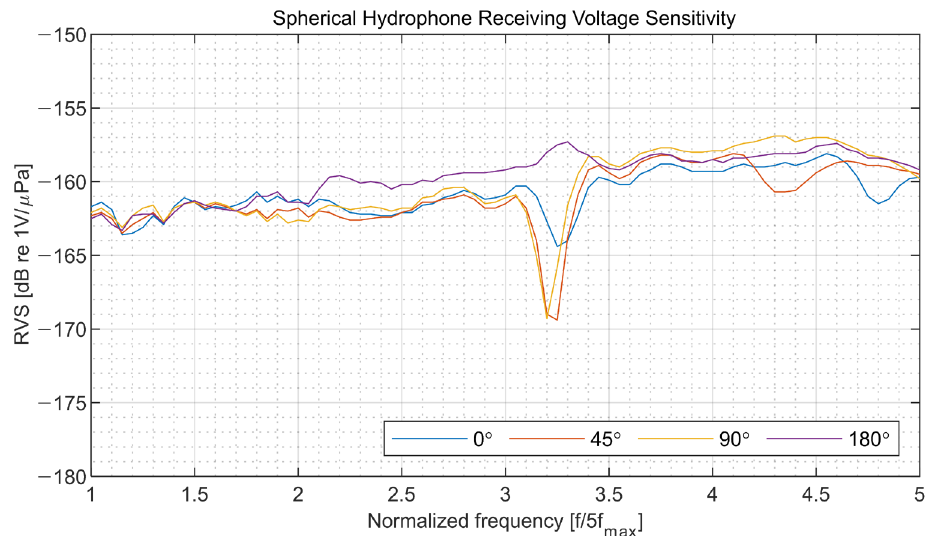
Figure 11. Measured receiving voltage sensitivity (RVS) of the spherical hydrophone with 31.6 dB amplification.